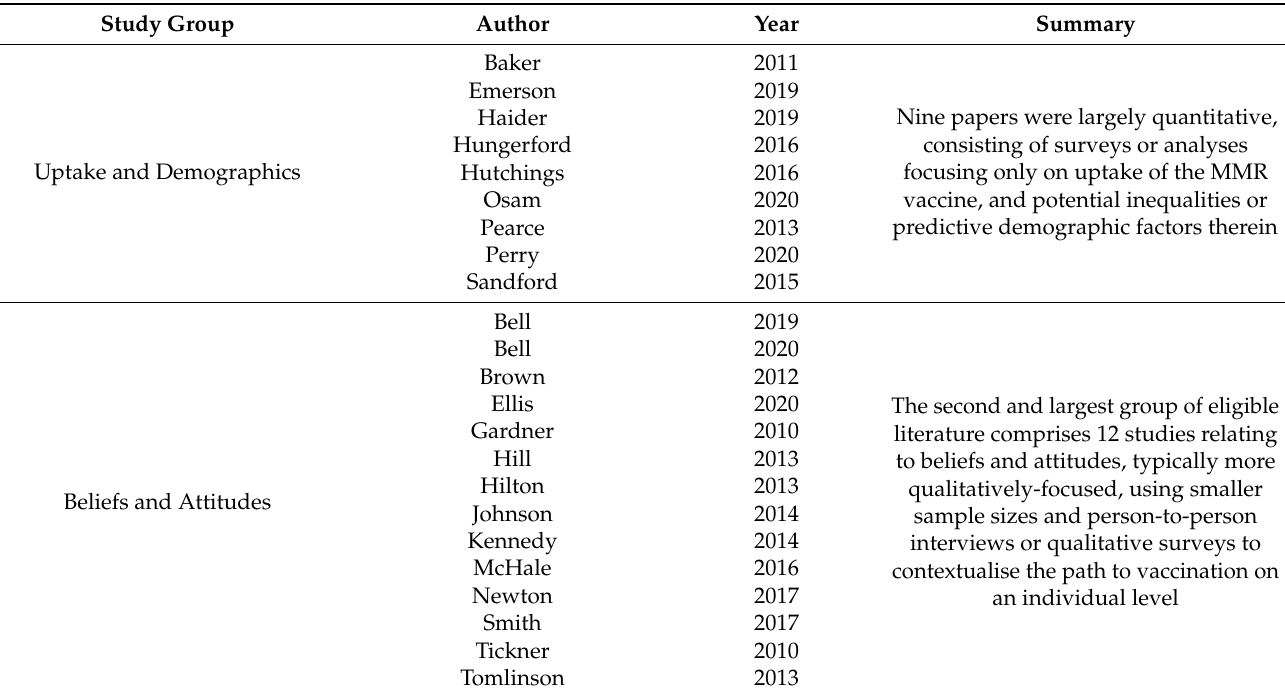
Table 1. List of papers by